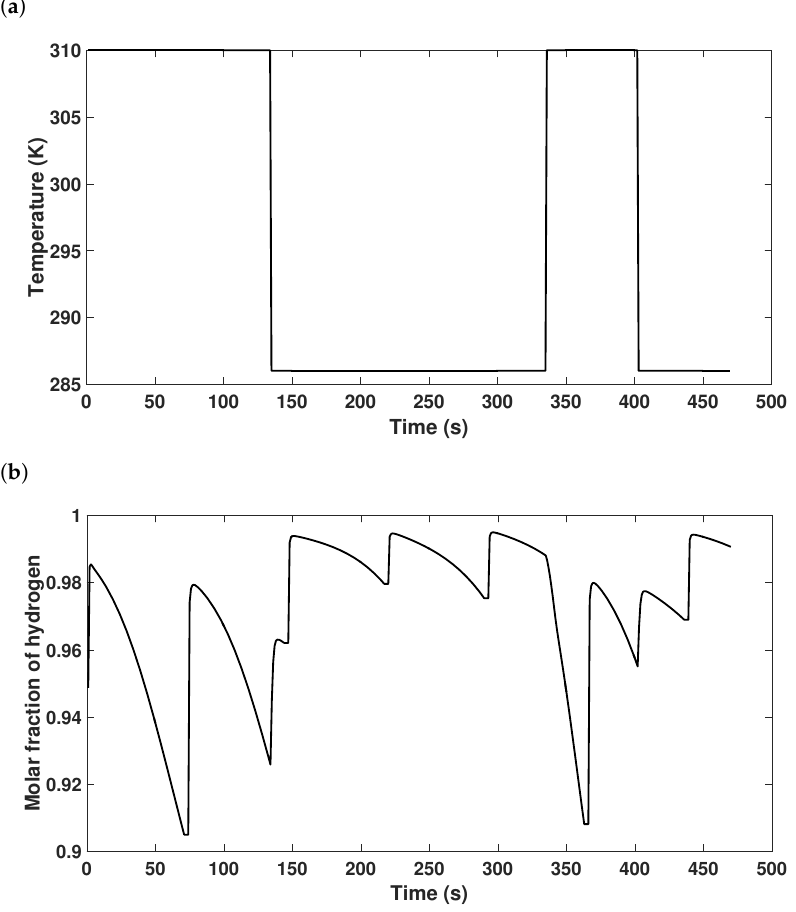
Figure 6. Output data obtained from the 4 bit PRBS input with a sampling time of 1 s. ( a ) Input signal generated from a 4 bit PRBS with a sampling time of 1 s. ( b ) Output signals (hydrogen